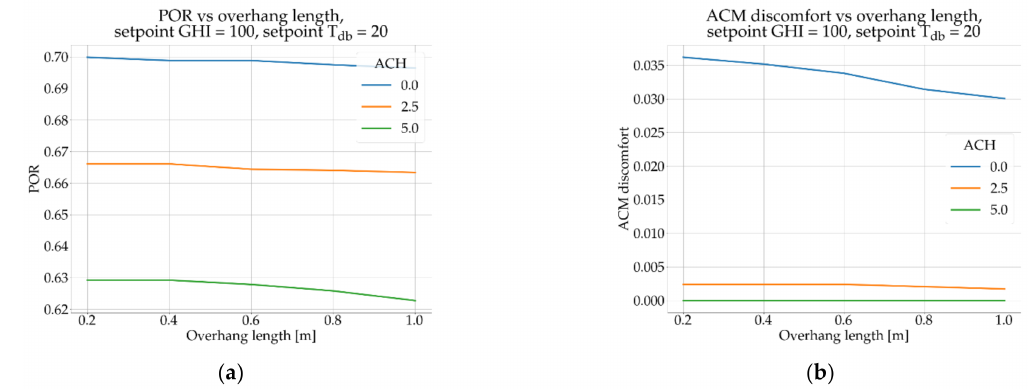
Figure 10. Thermal discomfort expressed with ( a ) POR and ( b ) adaptive categories at varying overhang length and ACH in Rome.